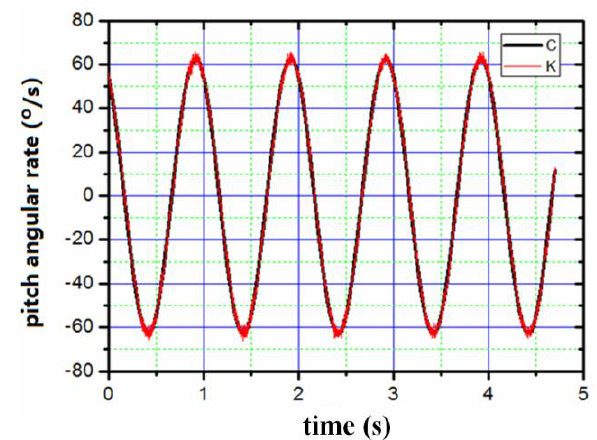
Figure 10. Comparison between the input of pitch angular rate and the output of pitch angular rate. C ： the input of yaw angular rate ； K ： the output of yaw angular